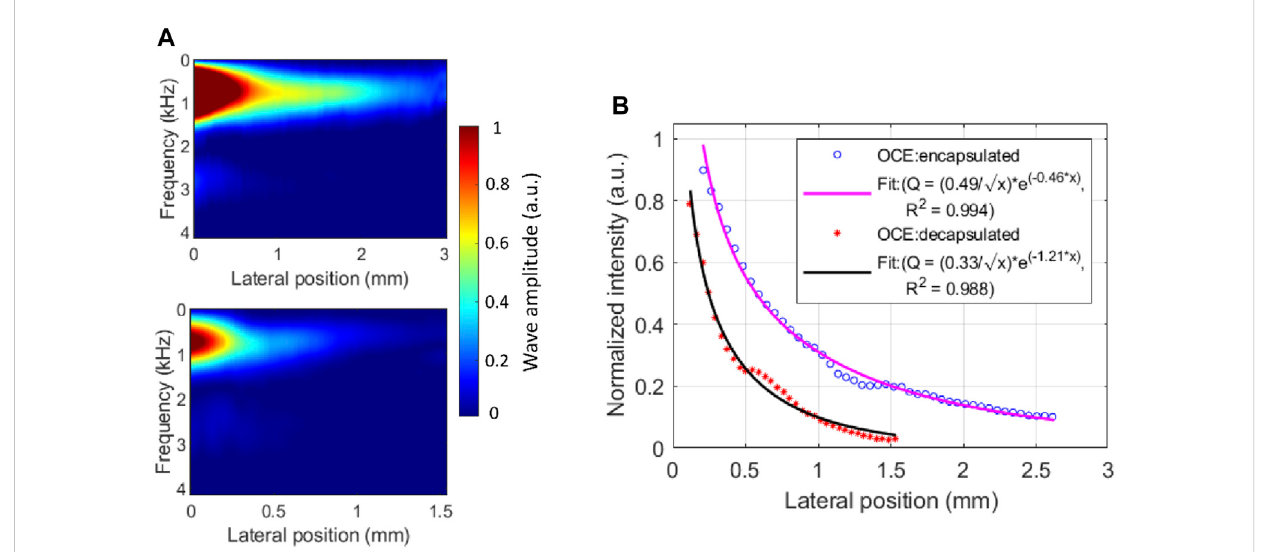
FIGURE 5 Elastic wave attenuation characteristics in a typical porcine eye lens. (A) The energy distribution map of laterally propagating elastic wave in encapsulated (top) and decapsulated (bottom) lens. (B) The normalized spatial distribution curve of the peak intensity and the exponential fi tting before and after capsule removal. The peak intensity occurred at a center frequency of ~706 Hz. At the center frequency, the mean attenuation coef fi cient is higher in the decapsulated lens ( α (cid:1) 1 . 21 mm − 1 ) than in the encapsulated lens ( α (cid:1) 0 . 46 mm − 1 ).